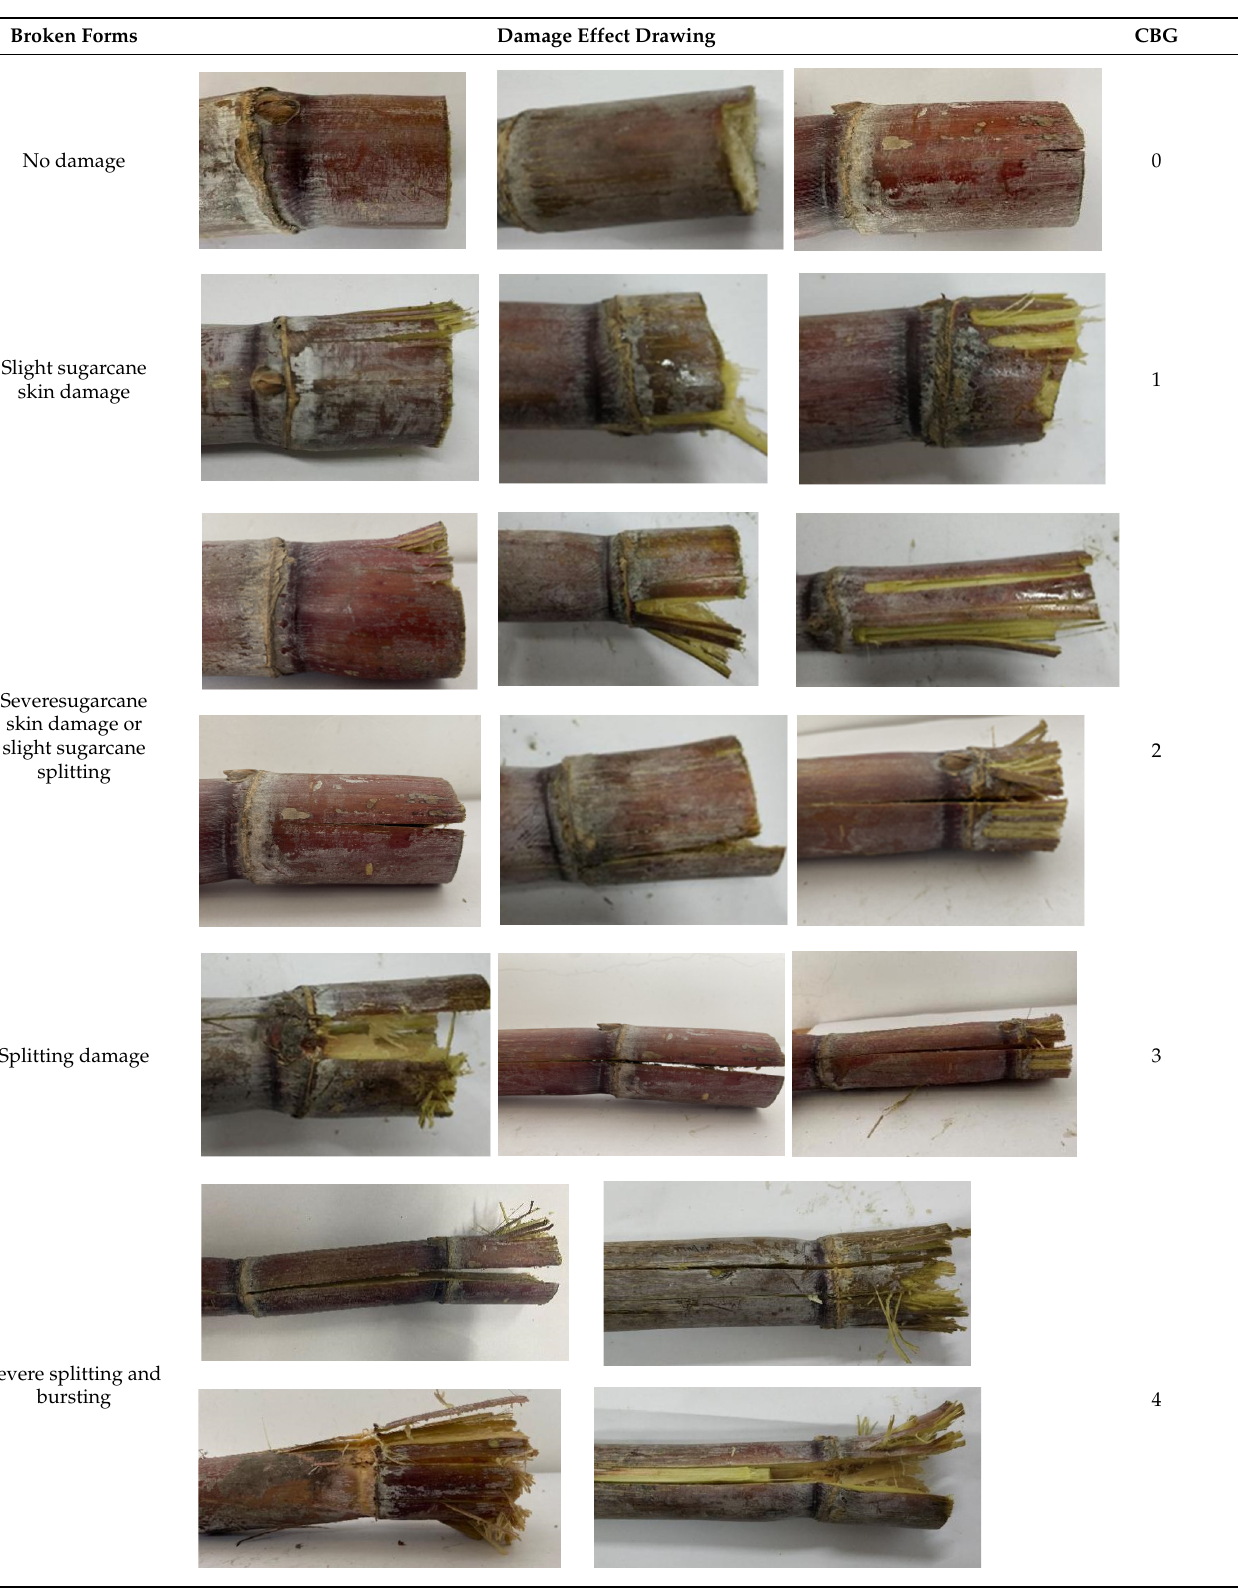
Table 2. Forms and grades of ratoon cutting damage.